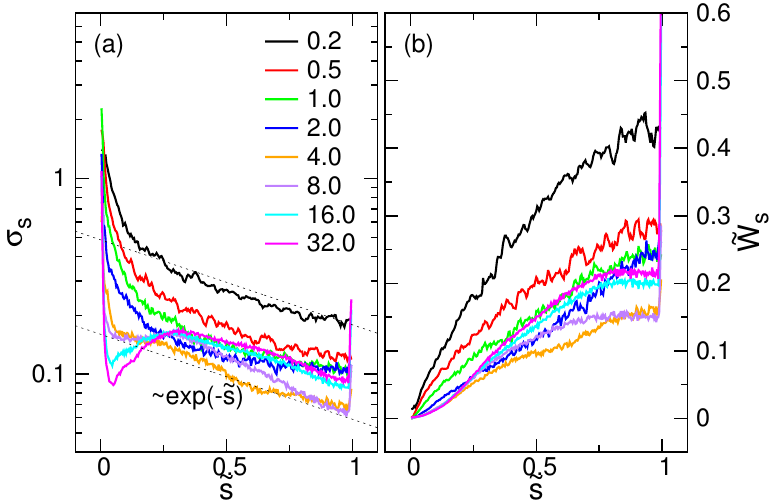
Figure 12. ( a ) Fitting parameter σ s as a function of the scaled coordinate ˜ s at different E fields; ( b ) relative width ˜ W s of the log-normal distribution, calculated by 2sinh ( The field strengths E are indicated in the figure. The number of monomers N is equal to